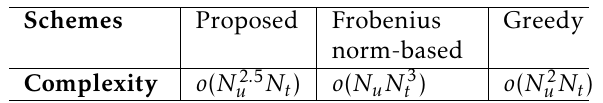
Figure 2. Achievable sum rate with K = 6,Nu=10